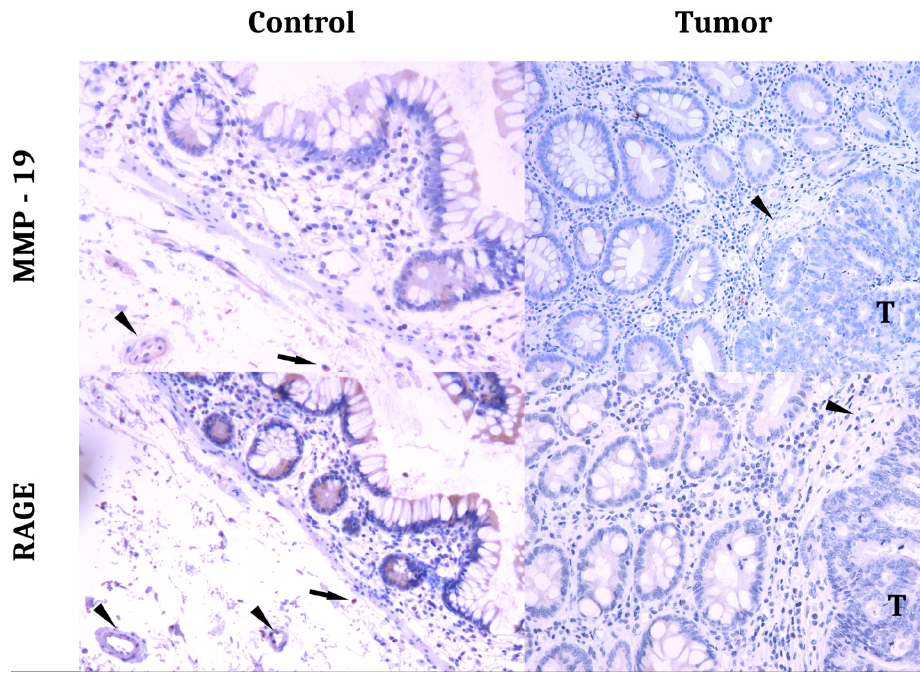
Fig. 1. Differences in MMP-19 and RAGE expression in healthy tissues in control group with tissues in proximity of tumor (letter T) in tumor group. Mild to moderate intensity of staining in epithelia, macrophages (arrows) and vessels (arrowheads) in control group compared to decreased intensity of staining in epithelia proximal to tumor as well as complete loss of staining in macrophages and blood vessels. Original magnification